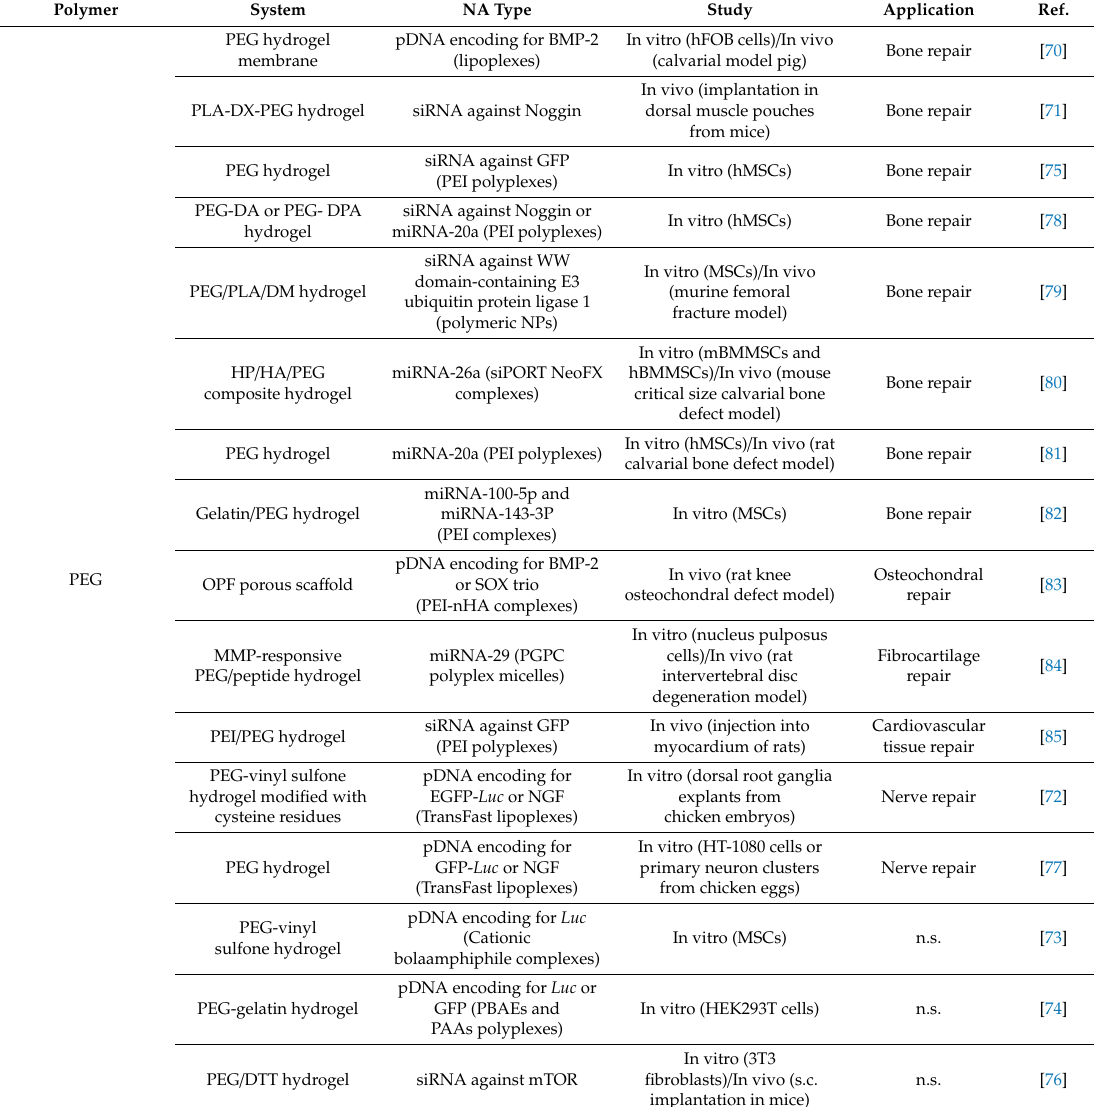
Table 1. Controlled nonviral gene delivery from synthetic-based